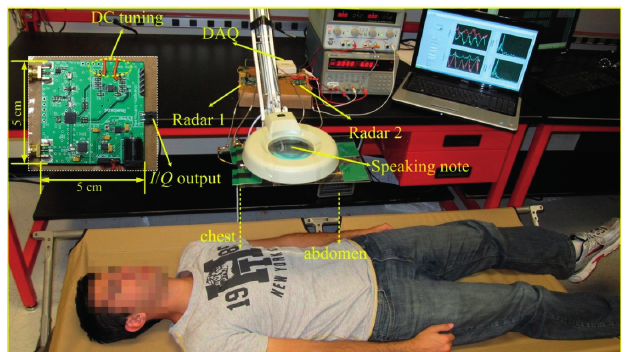
Figure 3. The Experimental setup of the DC coupled multi-radar system for assessment of different respiration patterns at chest and abdomen. Inset shows the photograph of the designed miniature DC coupled radar